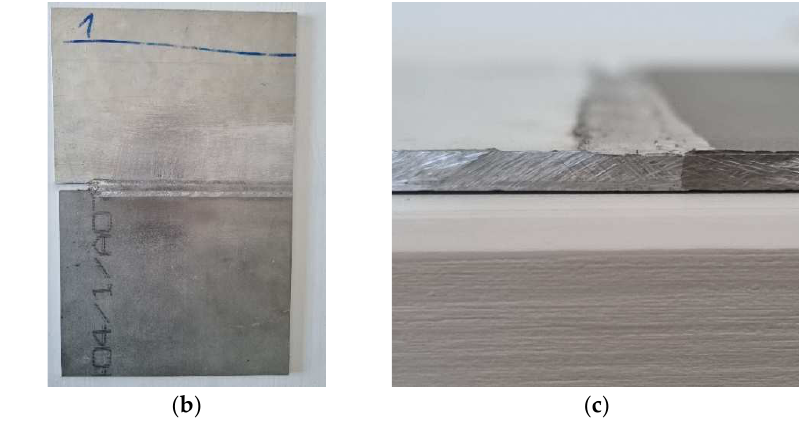
Figure 5. A joining of the AlMg3 + X2CrNiMo17-12-2 alloy; ( a ) first stage was the joining on one side, ( b ) the root of the joining, and ( c ) section of the joint.